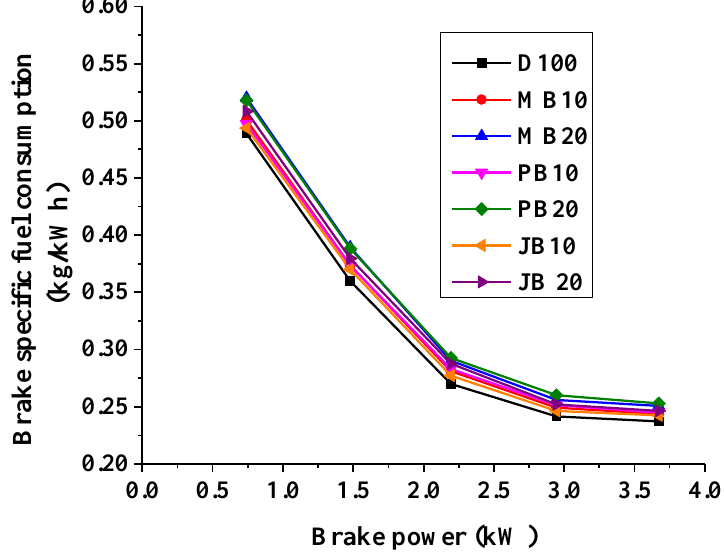
Figure 3. Comparison of brake specific fuel consumption with respect to engine loading for microalgae, polanga, and jatropha biodiesel blends.